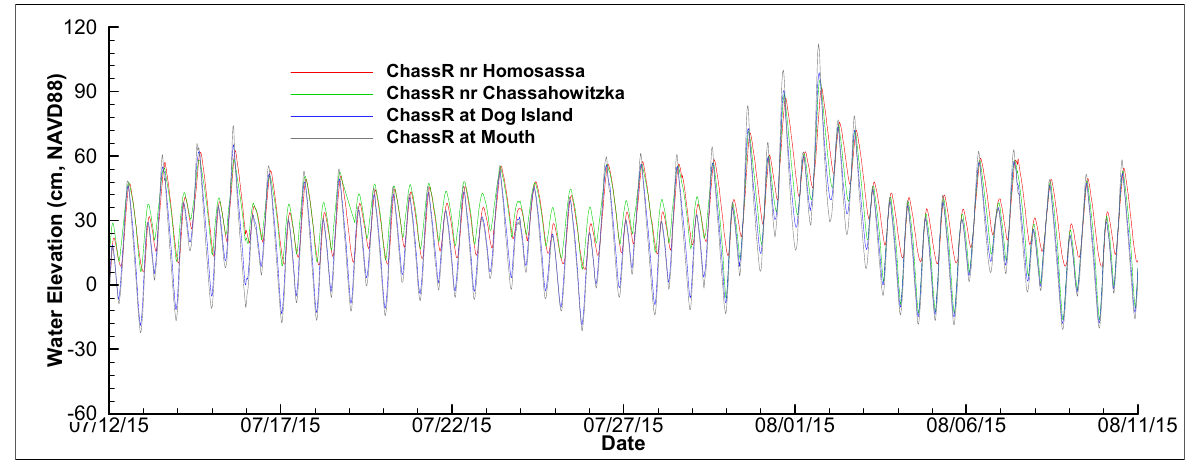
Figure 5. Measured water elevations at the CRH (red line), CRC (green line), CRD (blue line), and CRM (black line) stations in the Chassahowitzka River during a 30-day period, from 13 July 2015 to 11 August 2015.